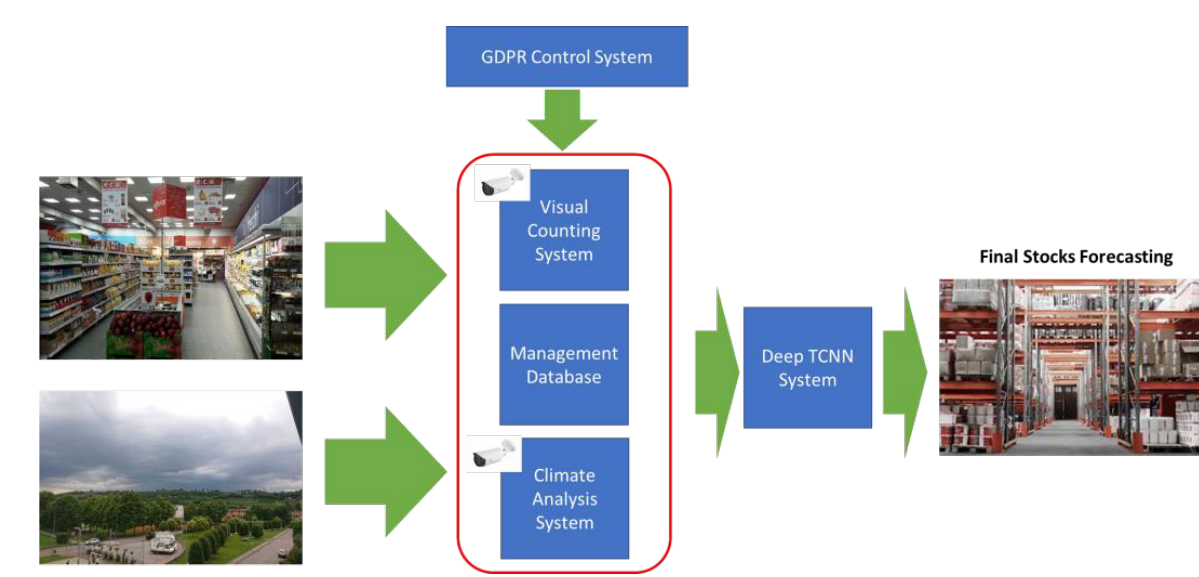
Figure 1. Overall scheme of the proposed pipeline.